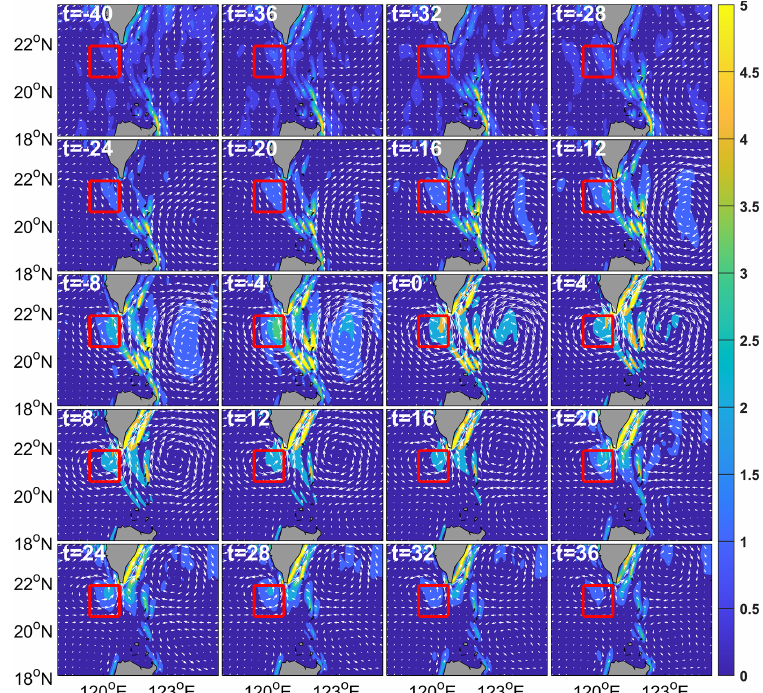
Figure 11. Evolution process of absolute value of zonal horizontal velocity shear ( ∂v ) for AE mode of counter-rotating eddy pair in LS ∂x based on HYCOM data. Shading represents zonal horizontal velocity shear (units of 10 − 6 s − 2 ). Vector represents the current anomaly. t in the top left-hand corner of each panel denotes days before (negative value) or after (positive value) the AE mode of counter-rotating eddy pair reached the maximum ( t = 0). t = 0 corresponds to time of Fig. 3b. Red boxes on west side of LS cover 20.5–21.8 ◦ N, 119.4–120.7 ◦ E and represent location of CE on west side of